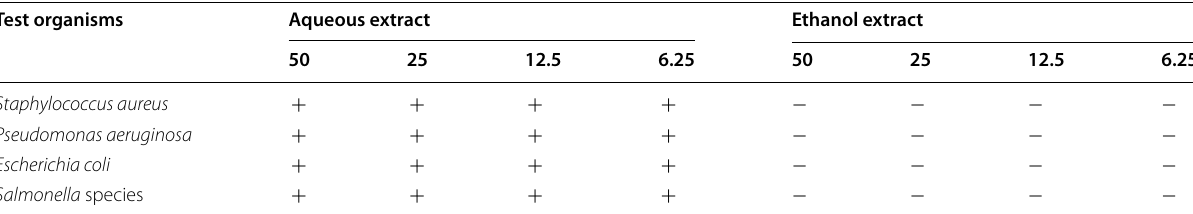
Table 6 Minimum inhibitory concentrations (mg/ml) of aqueous and ethanol extracts of Moringa oleifera leaf Test